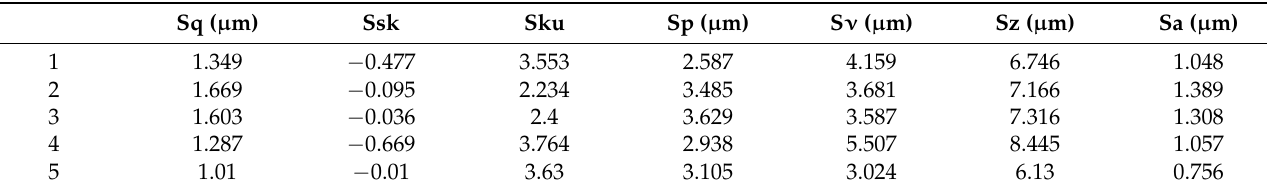
Table 3. Roughness changes at the slow propagation